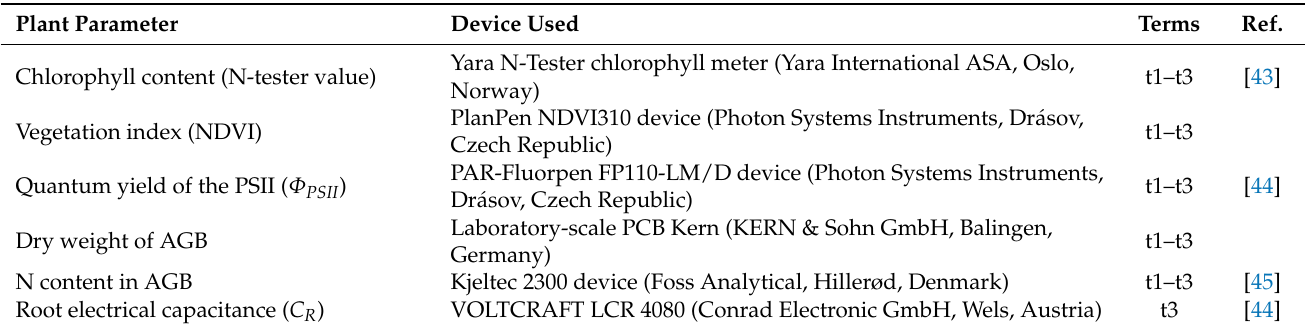
Table 3. Observed plant growth parameters.